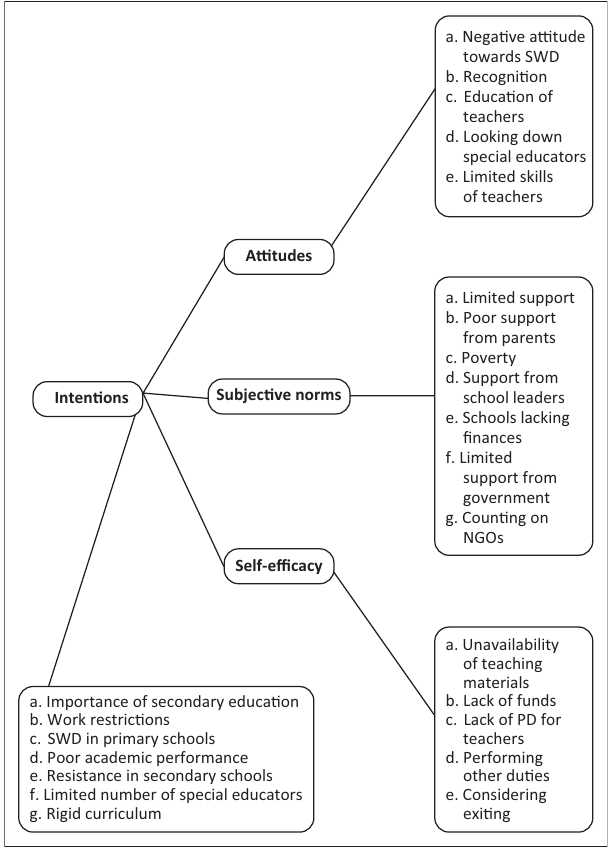
FIGURE 1: Summary of themes and